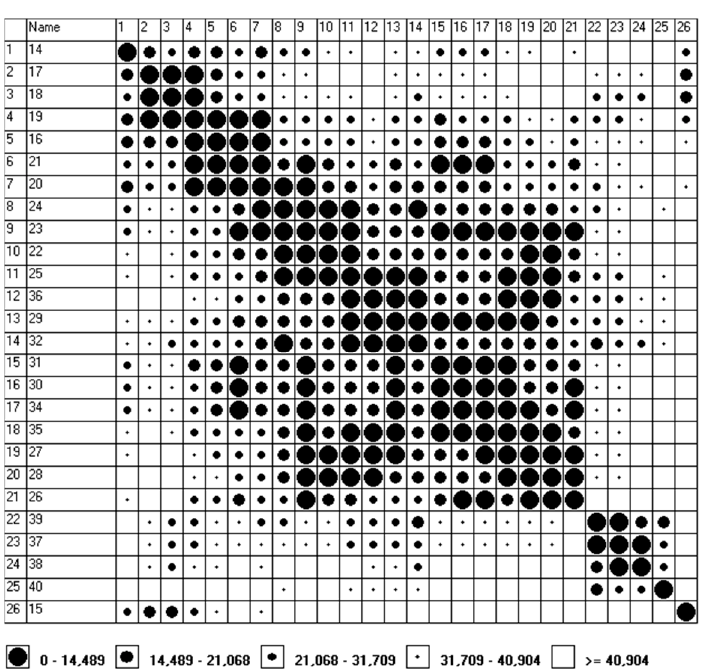
Figure 2. Czekanowski’s diagram—“summer period”. (The MaCzek v. 3.0 program generates the graphic image of the grouping of objects by itself: the first column and the horizontal axis (the row at the top of the drawing) contain the numbers assigned to the following weeks (the second column is the number of the weeks counted from the beginning of the year).)